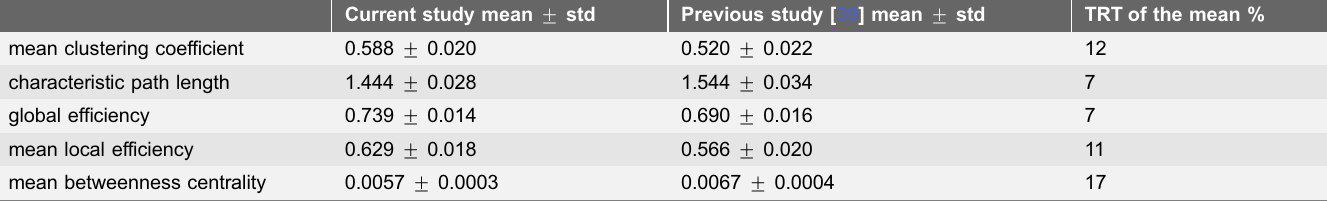
Table 2. Comparison of global graph measures derived from subject-specific weighted networks between two independent